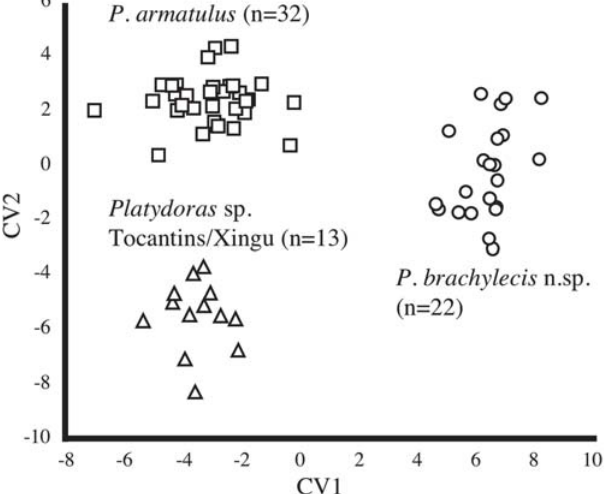
Fig. 2. Scatter plot of individual scores for three groups of Platydoras resulting from SFCVA of both lateral and dorsal trussnets. Canonical variate axes 1 and 2 explain 52.48% and 22.8% of the variance,